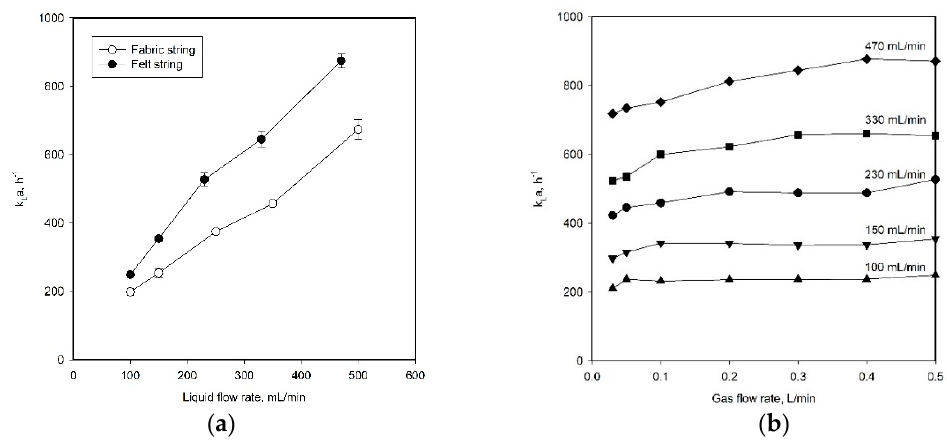
Figure 4. Mass transfer performance of the SFR using felt strings: ( a ) comparison of the volumetric mass transfer coefficients for oxygen with fabric strings (open circles) and felt strings (closed circles) and ( b ) effect of the gas flow rate on the mass transfer coefficients.